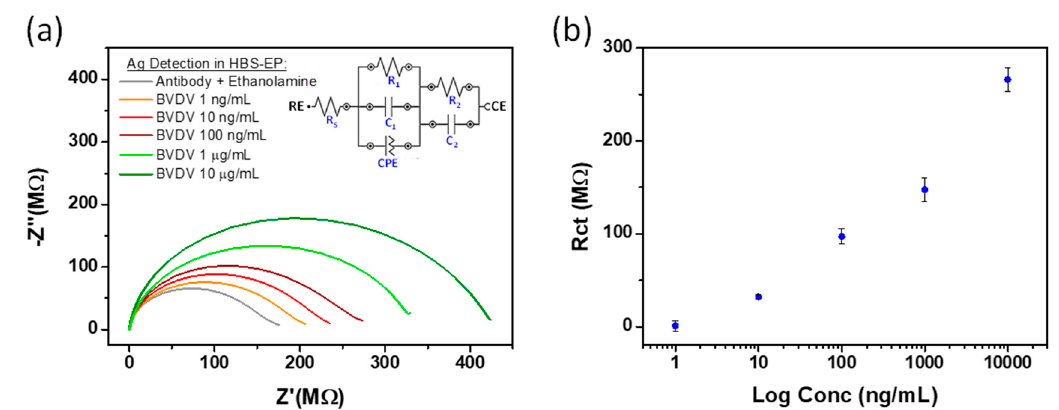
Figure 8. ( a ) Nyquist plots of 1mM FcCOOH showing quantitative detection of recombinant BVDV1 Erns protein in HBS-EP buffer. ( b ) Semi-log relationship of the charge transfer resistance versus virus concentration (error bars represent n = 3 replicates) background subtracted using ethanolamine baseline.